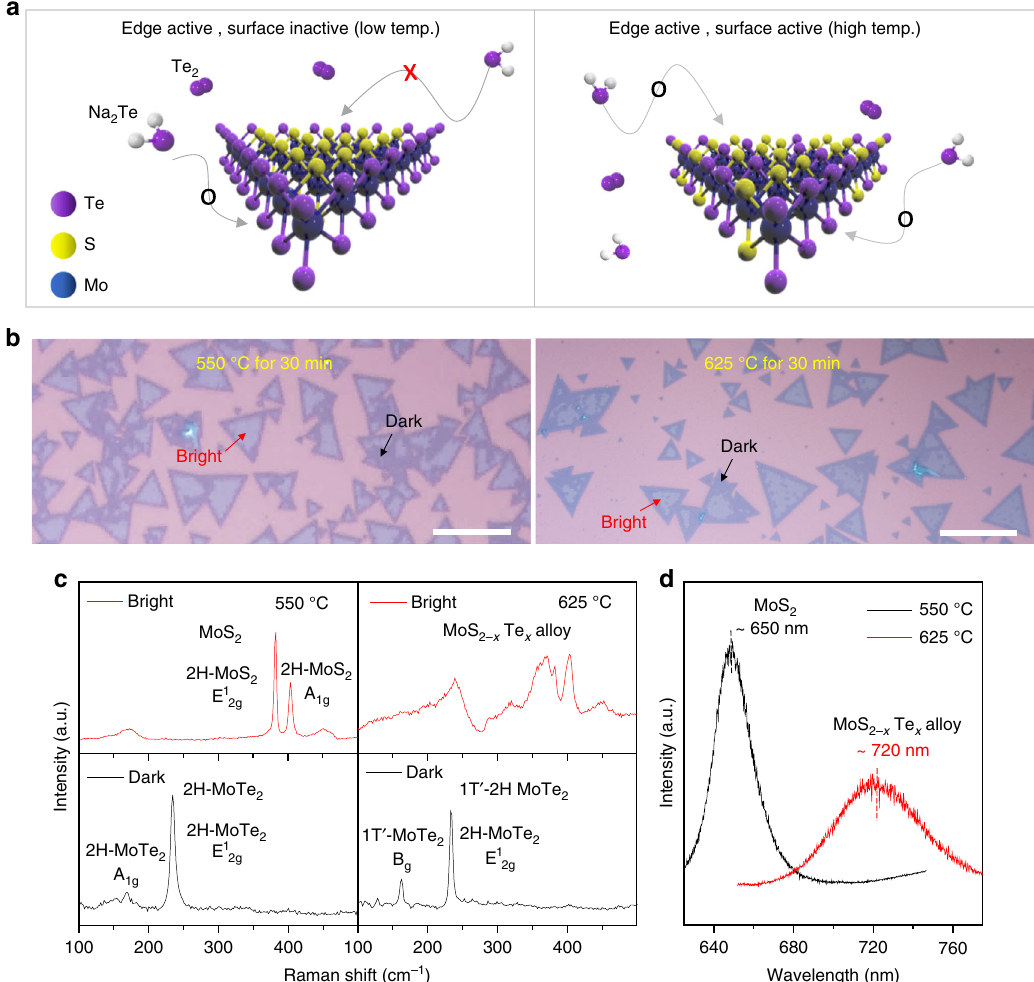
Fig. 4 Temperature-dependent tellurization behavior of MoS 2 . a Schematic for tellurization behavior of MoS 2 converted at low temperature and high temperature. Only the edge site of the MoS 2 fl akes is favored over converted MoTe 2 at a relatively low tellurization temperature, while both the edges and surfaces of the fl akes are active for tellurization at a high tellurization temperature. b Optical images of tellurized monolayer MoS 2 fl akes at 550 °C and 625 °C, respectively. There are two distinct regions in terms of the optical contrast (bright and dark) in the tellurized MoS 2 samples; scale bars, 50 μ m. c Raman spectra of tellurized MoS 2 in bright and dark regions at 550°C and 625 °C, respectively. d PL spectra of the bright regions also support that negligible Te substitution happened at 550 °C. This indicates that only the edge sites of MoS 2 were active for tellurization at 550